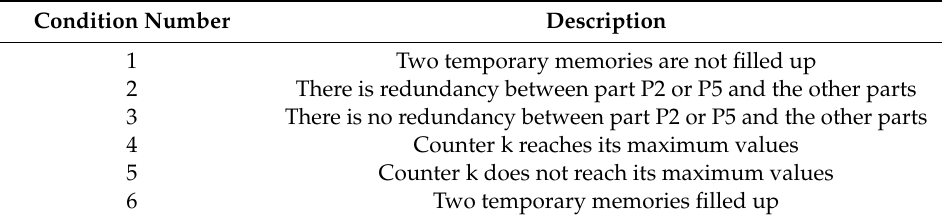
Table 1. Transition conditions for state